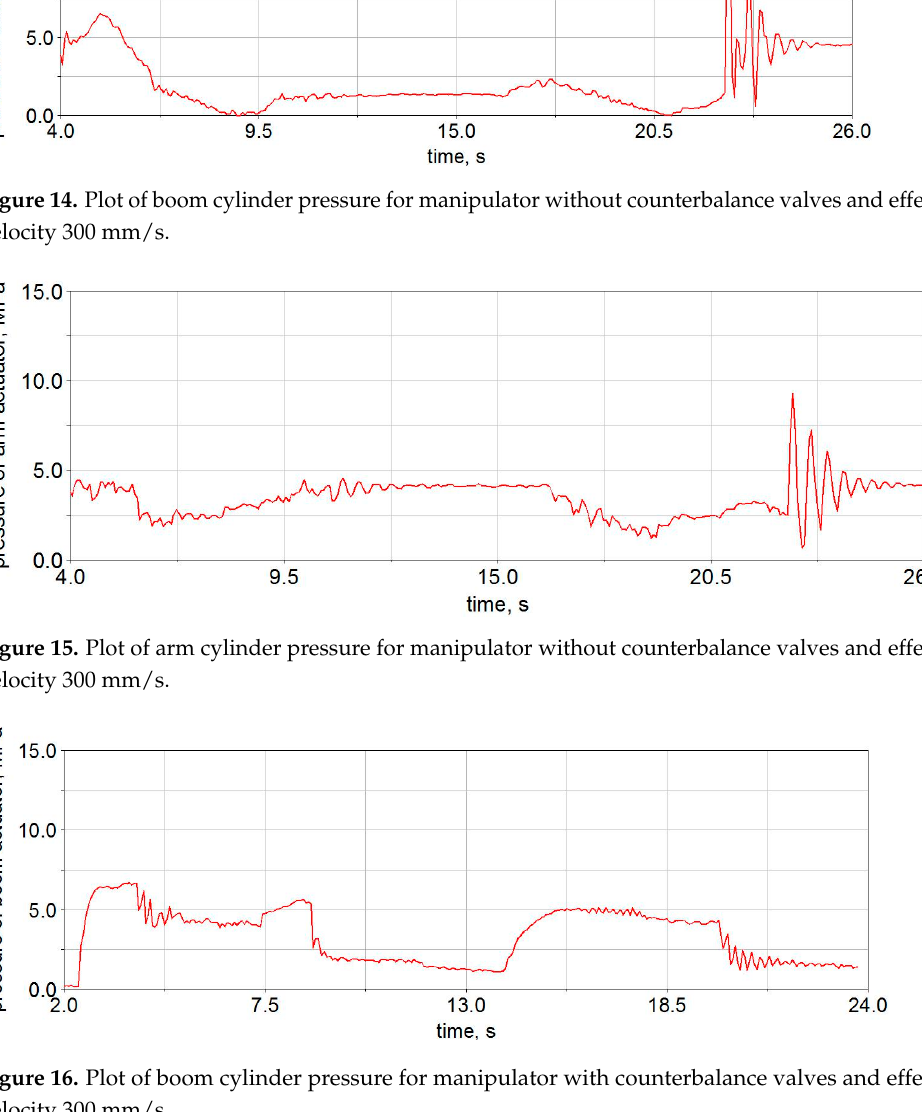
Figure 17. Plot of arm cylinder pressure for manipulator with counterbalance valves and effector velocity 300 mm/s.